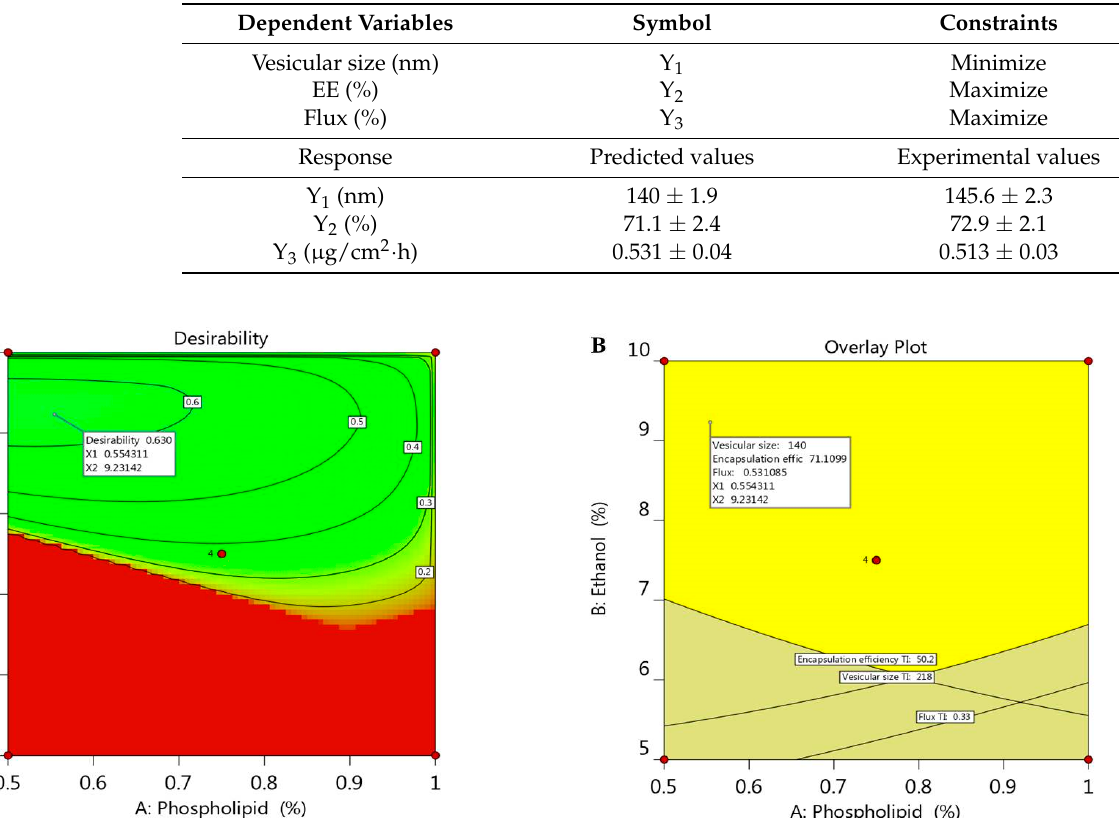
Table 3. Predicted and experimental value of response at the optimized conditions. Table 3. predicted and experimental value of response at the optimized conditions.